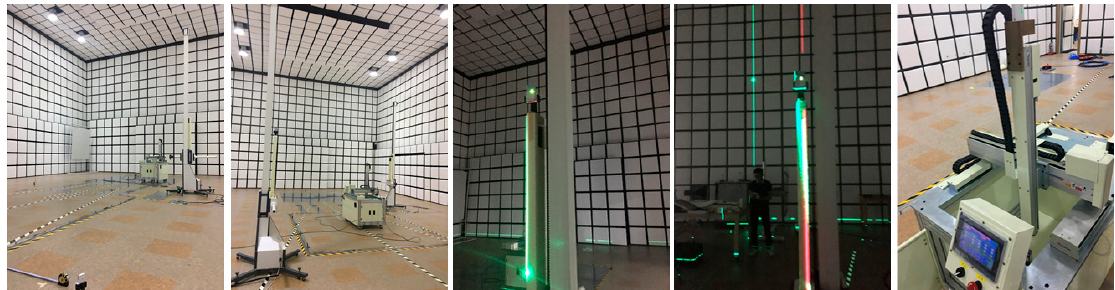
Figure 8. Electromagnetic anechoic chamber test environment.